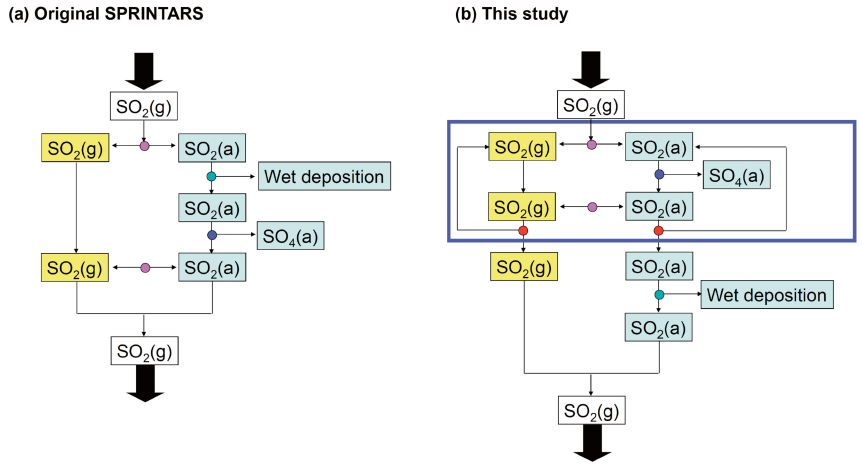
Fig. 3. A flowchart for aqueous-phase reaction of SO 2 in (a) the original SPRINTARS and (b) this study. The SO 2 in yellow and aqua represent SO 2 in the gas-phase and in the aqueous-phase, respectively. The pink, aqua, blue, and red circles correspond to the process of gas-liquid phase equilibrium through Henry’s law, wet deposition, sulfate production reaction, and loop for the calculation in a sub-cycle timestep,